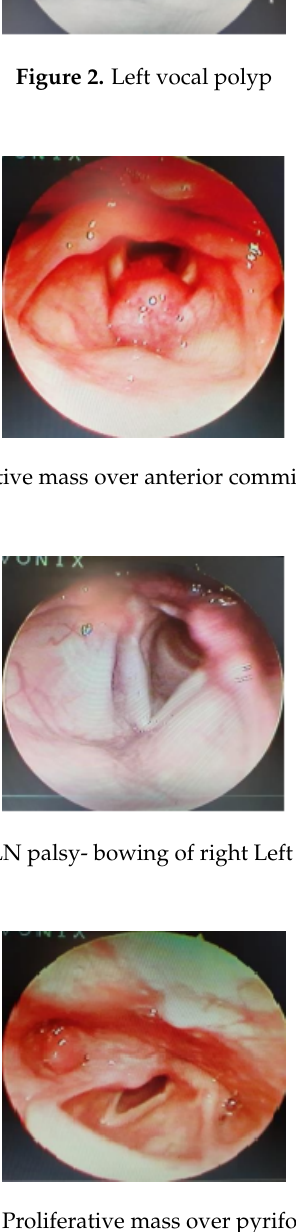
Figure 5. Proliferative mass over pyriform